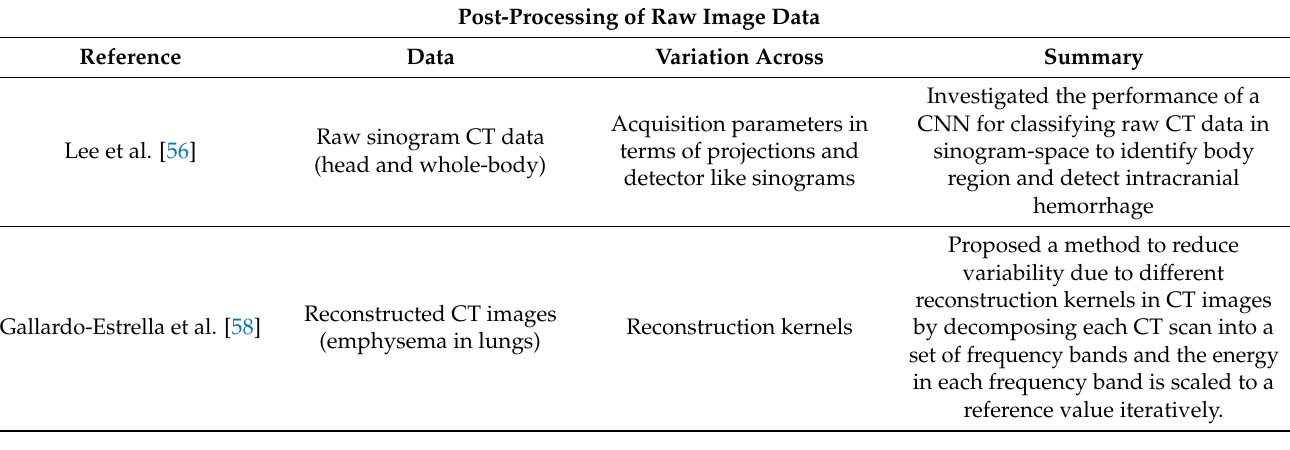
Table 2. Summary table of post-processing methods of raw sensor-level image